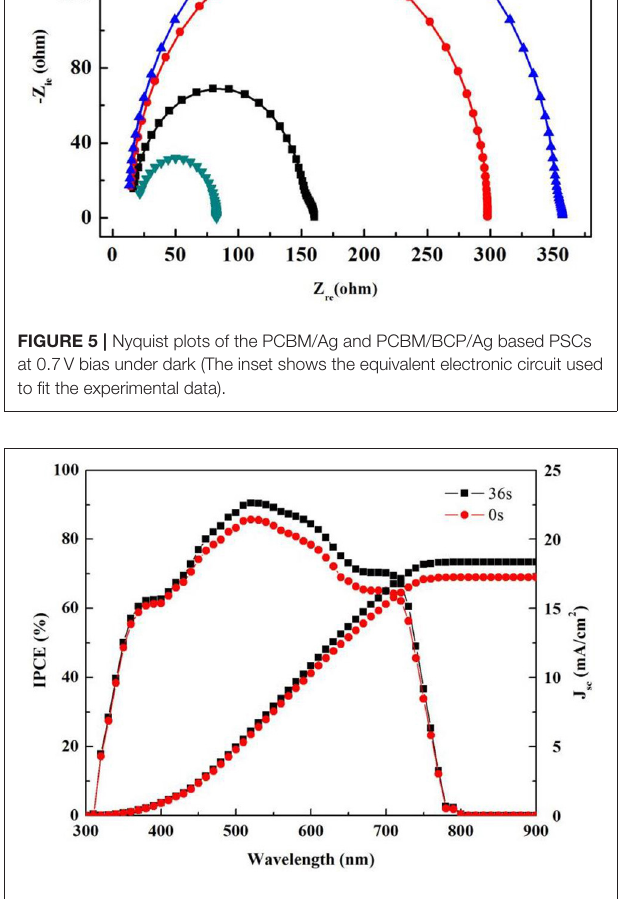
experimental data). R S represents the series resistance of